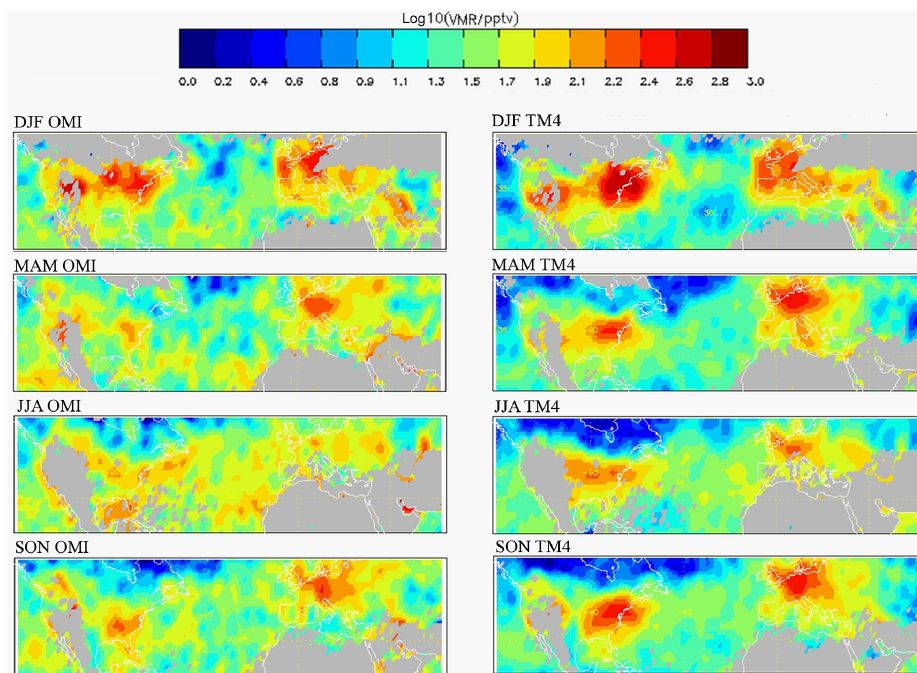
Figure 32. Same as Fig. 29 but at 720hPa in logarithmic